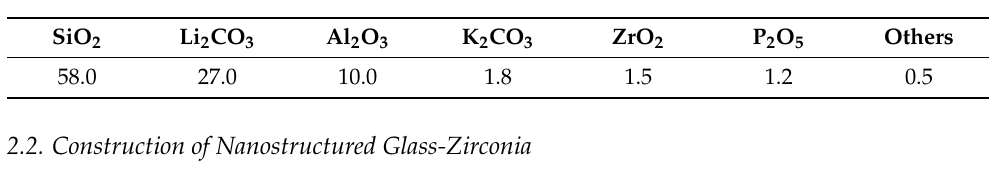
Table 1. The composition of glass powder (mol.%).